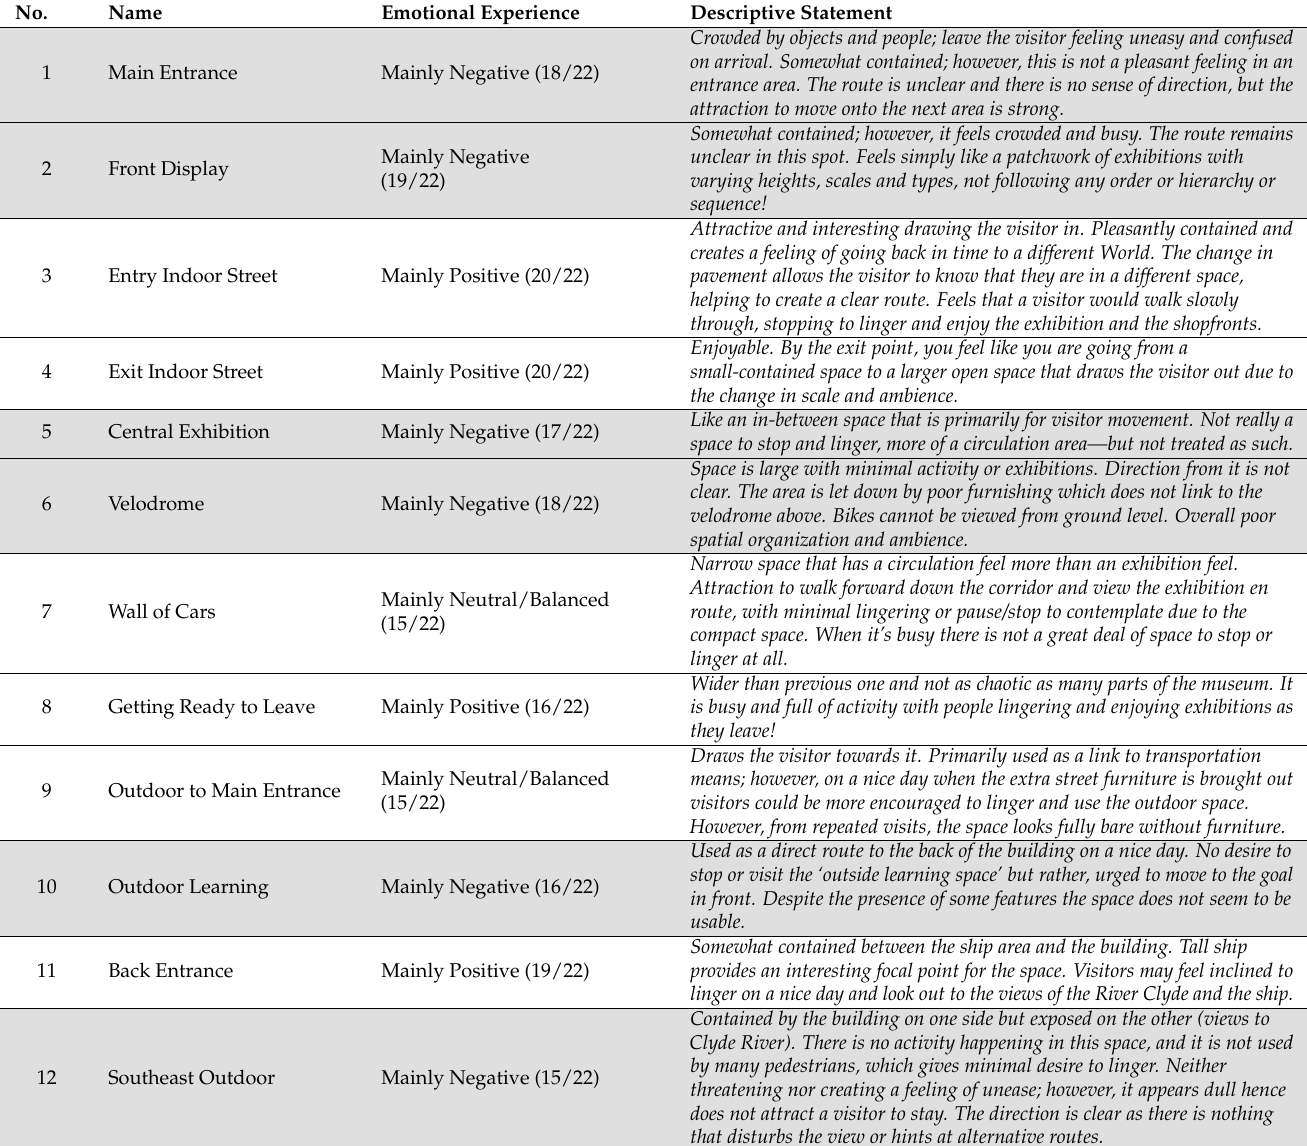
Table 6. Record of 22 users’ emotional experiences in the 12 numbered locations identified for examination at the Riverside Museum. (Locations mapped in Figure